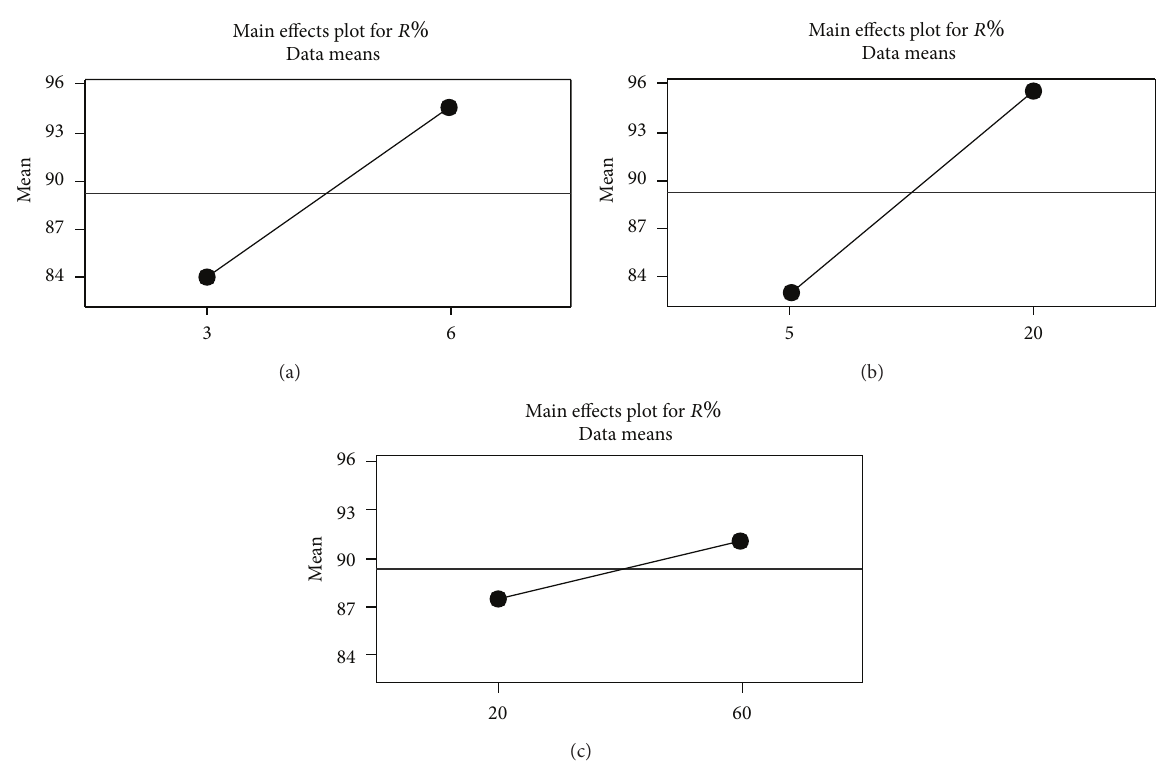
Figure 6: Main effects of analyzed